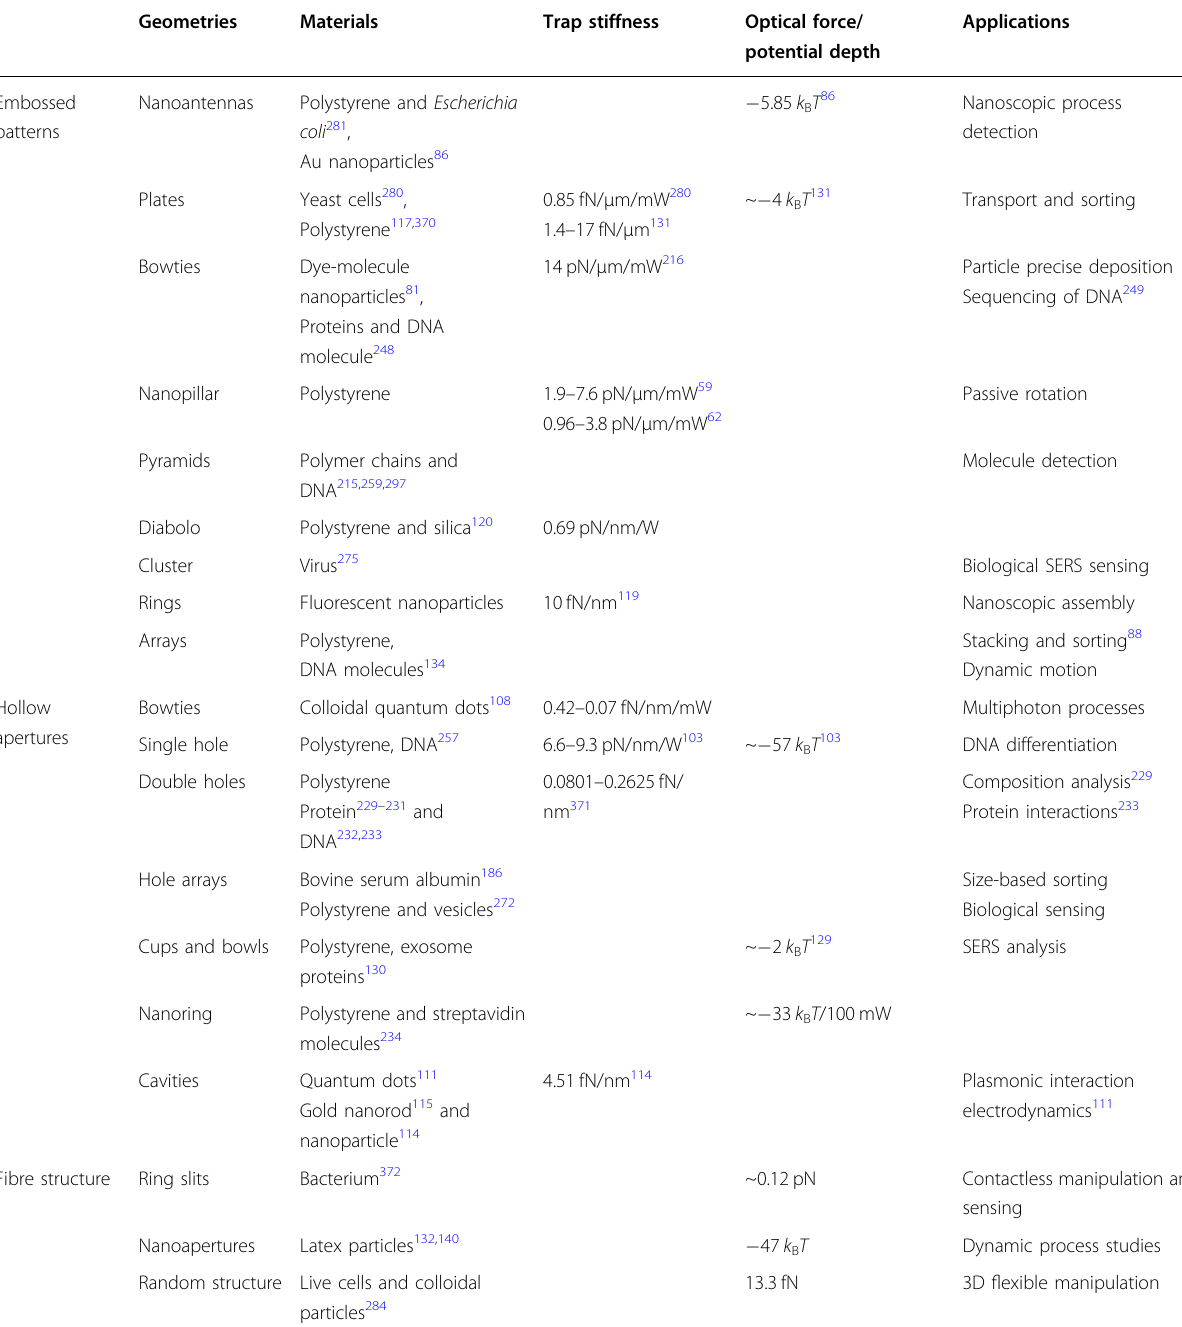
Table 1 Parameters, properties and applications of structural plasmonic tweezer con fi